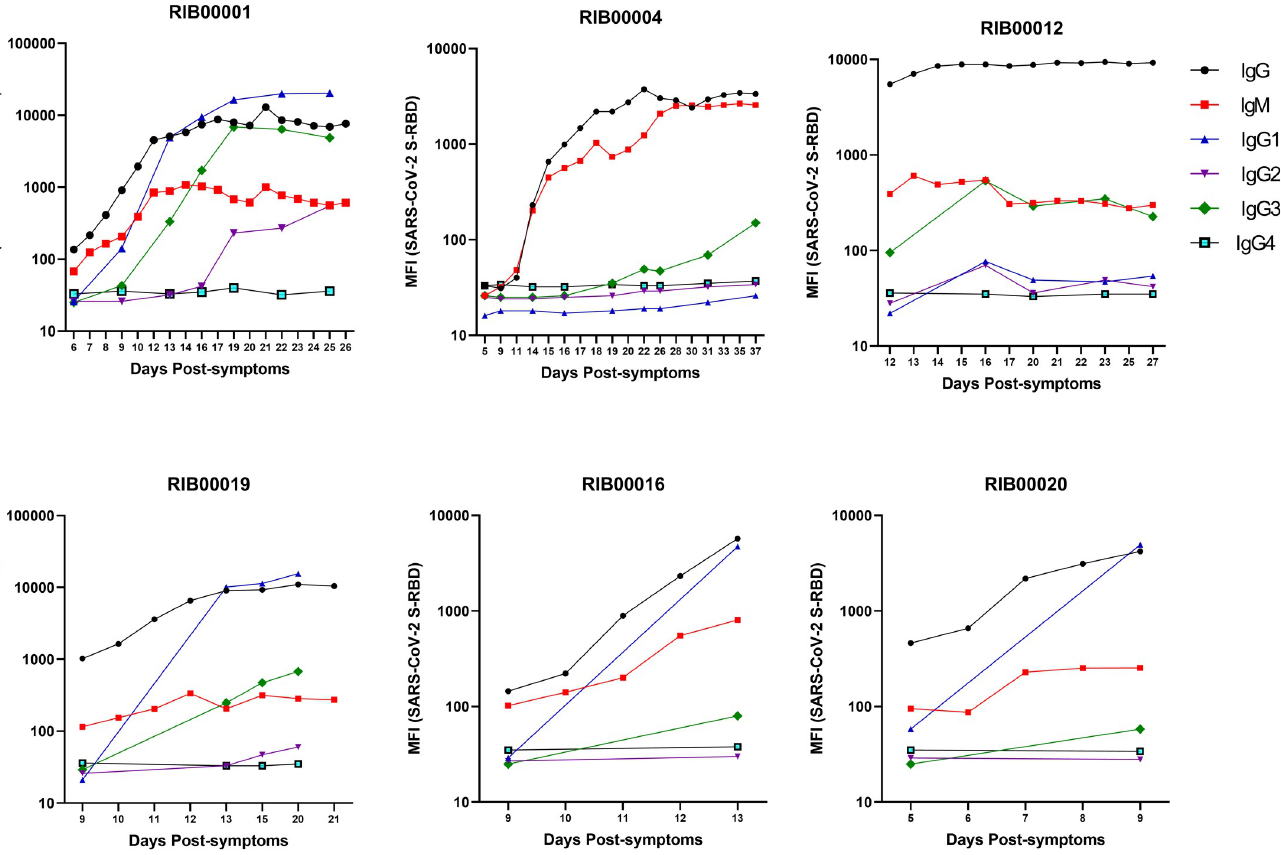
Fig 5. Kinetics of development of antibody subtypes (IgG, IgM, and IgG subtypes-1, 2, 3 and 4) in COVID-19 patients against SARS-CoV-2 S-RBD. Multiplex assays were performed individually to detect each antibody subtype against SARS-CoV-2 S-RBD, SARS-CoV S & N, MERS-CoV S-RBD, and S proteins of 4 common coronaviruses. Humoral immune responses against SARS-CoV-2 measured as MFI (log10) in longitudinal samples collected from six COVID-19 patients are shown at estimated time (days) from the onset of symptoms (as reported by patients) is shown.